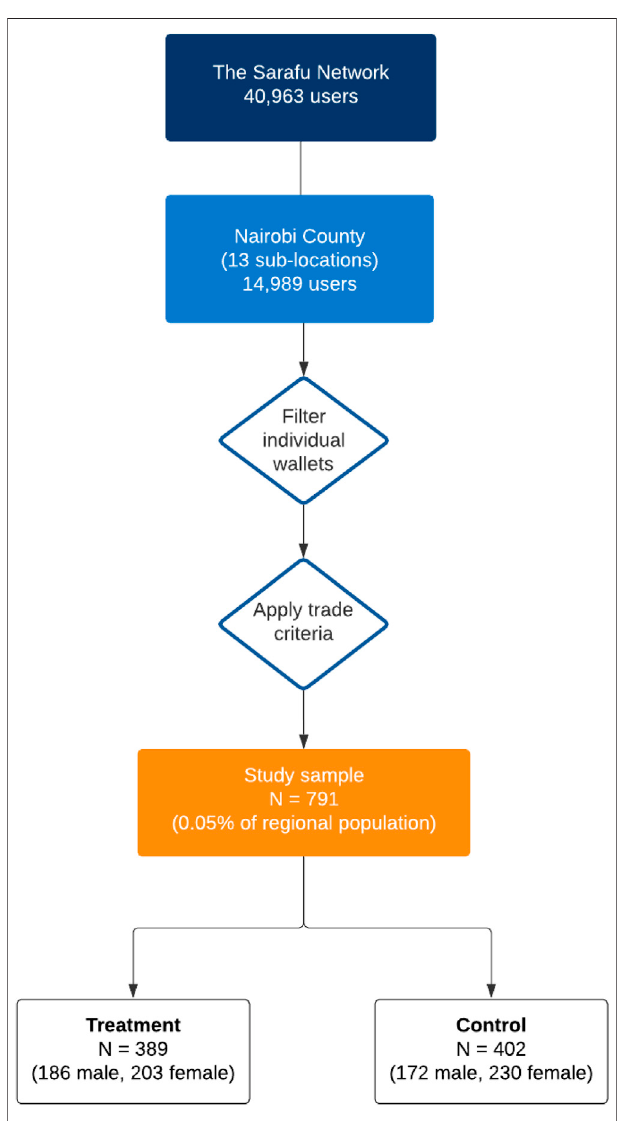
FIGURE 5 | Schematic diagram of the sample selection